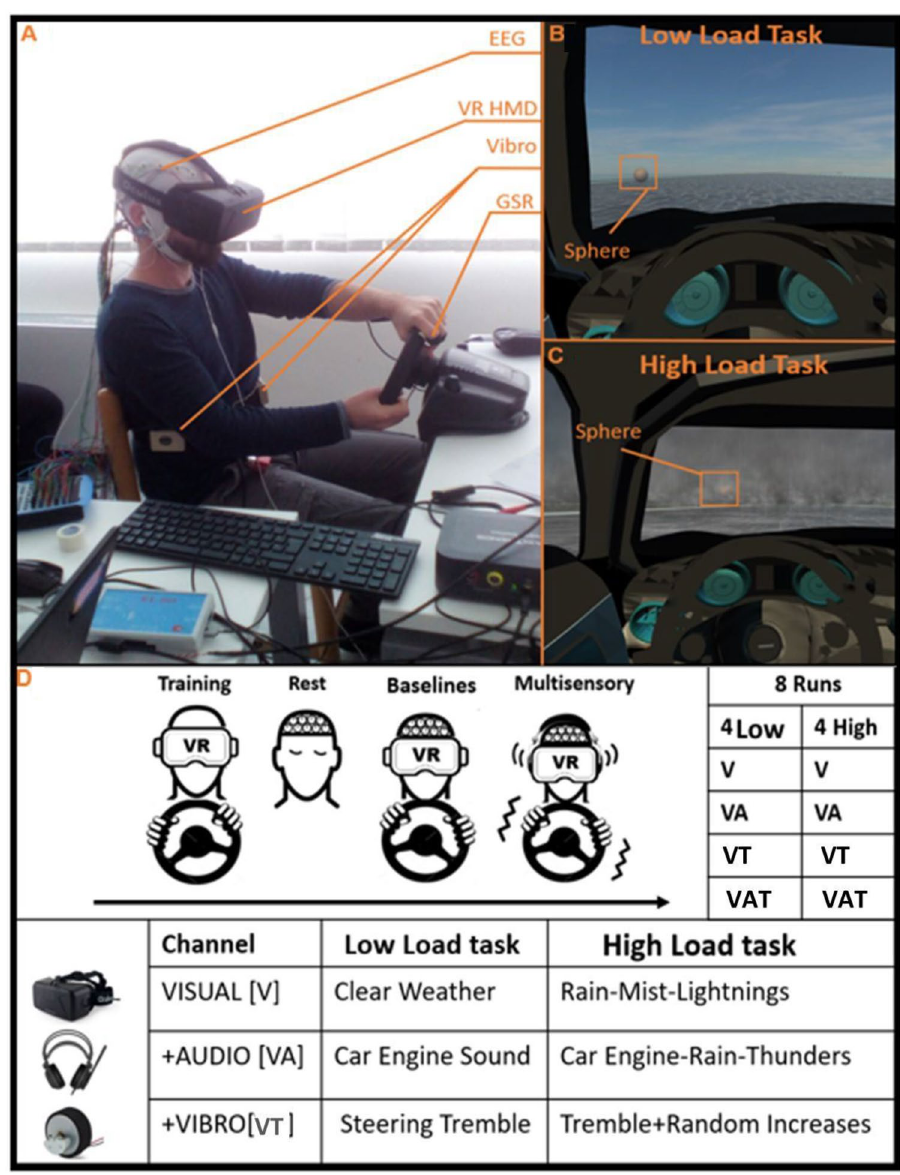
Figure 1. ( A ) Experimental setup; ( B ) the first-person perspective of the low and ( C ) the high load conditions. The target object (the sphere) is shown in the insert; ( D ) summary of the experimental procedure with the details for each task. Informed consent was obtained for this